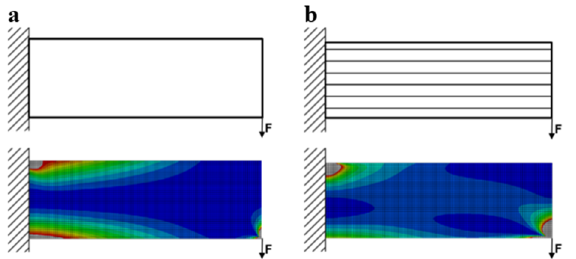
Figure 5. Qualitative comparison of the strain energy distribution for a cantilever beam consisting of isotropic material ( a ) and anisotropic, unidirectional reinforced material ( b ).